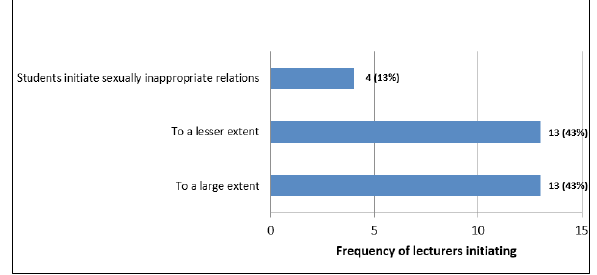
Figure 4: Extent to which lecturers initiate sexually transmitted marks according to respondents.